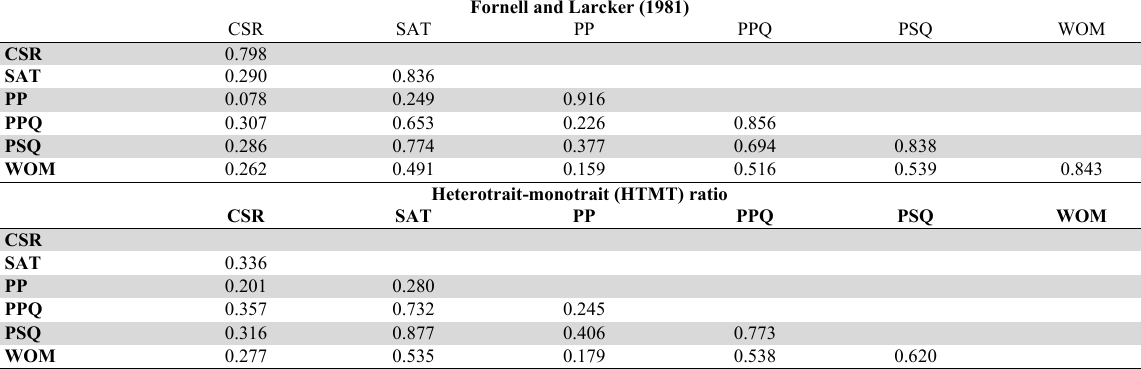
Fornell and Larcker (1981) and Heterotrait-monotrait (HTMT) ratio Fornell and Larcker (1981) CSR SAT PP PPQ PSQ